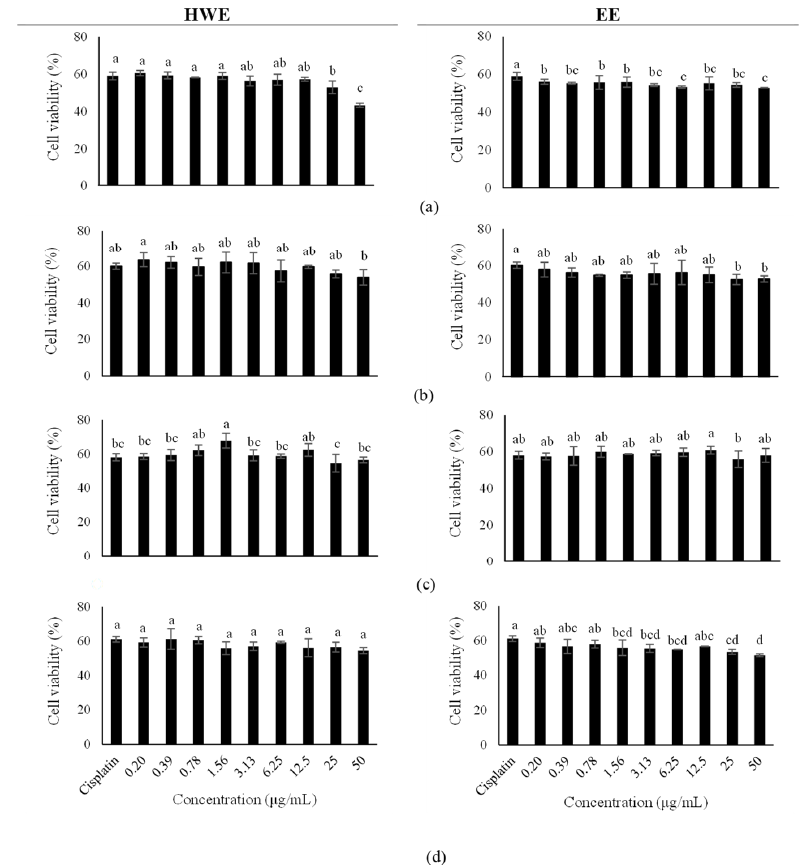
Figure 5. Cell viability against cisplatin ‐ induced oxidation to assess the protective effects on kidney cells of ( a ) turmeric; ( b ) gangwha mugwort; ( c ) glasswort; and ( d ) omija. The same letters have no significant differences.